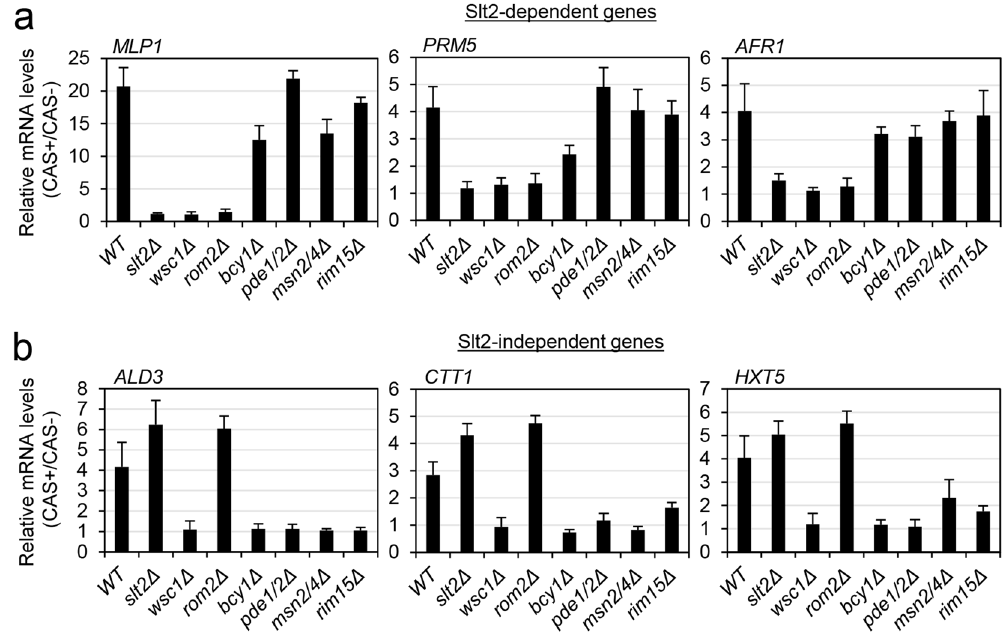
Figure 1. The transcriptional response elicited by caspofungin is regulated by the CWI and cAMP/PKA pathways. mRNA levels of several Slt2-dependent ( a ) and Slt2-independent ( b ) genes were analyzed by RT- qPCR in the indicated strains after 2 h of CAS treatment. Values represent the expression ratio between CAS- treated and non-treated cells. The mean and SD of at least three independent experiments are